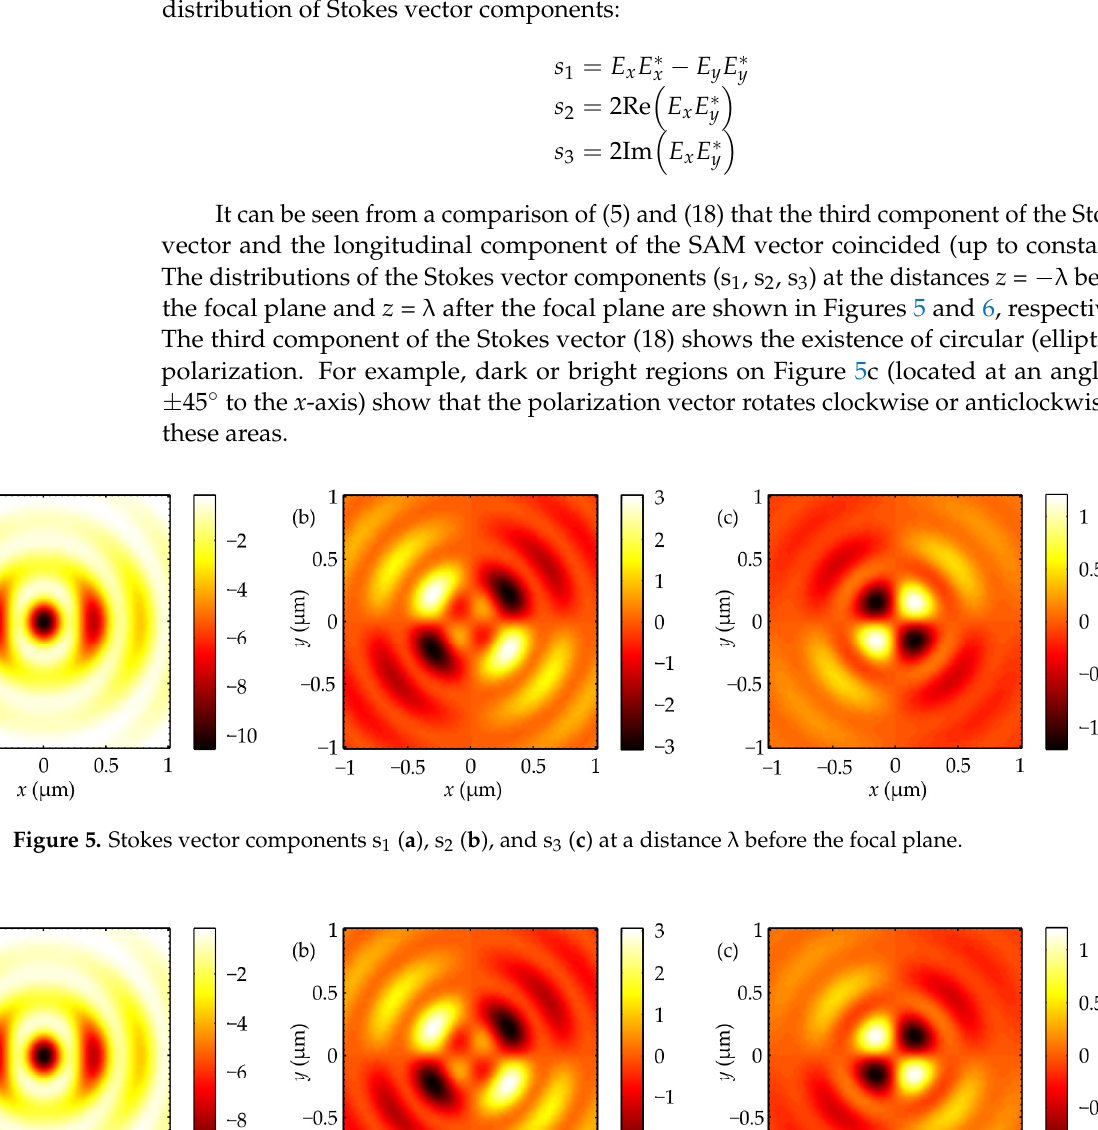
Figure 6. Stokes vector components s 1 ( a ), s 2 ( b ), and s 3 ( c ) at a distance λ after the focal plane.